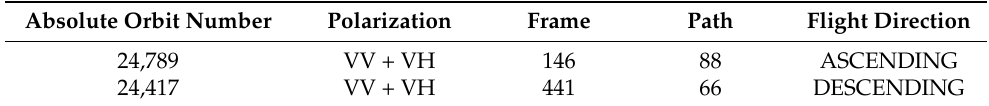
Table 1. SAR Stacks parameters